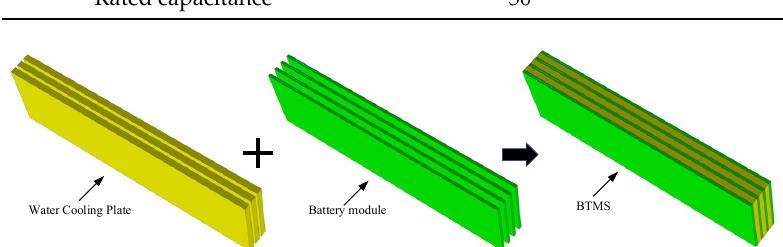
Figure 2. The water-cooling BTMS geometric structure.